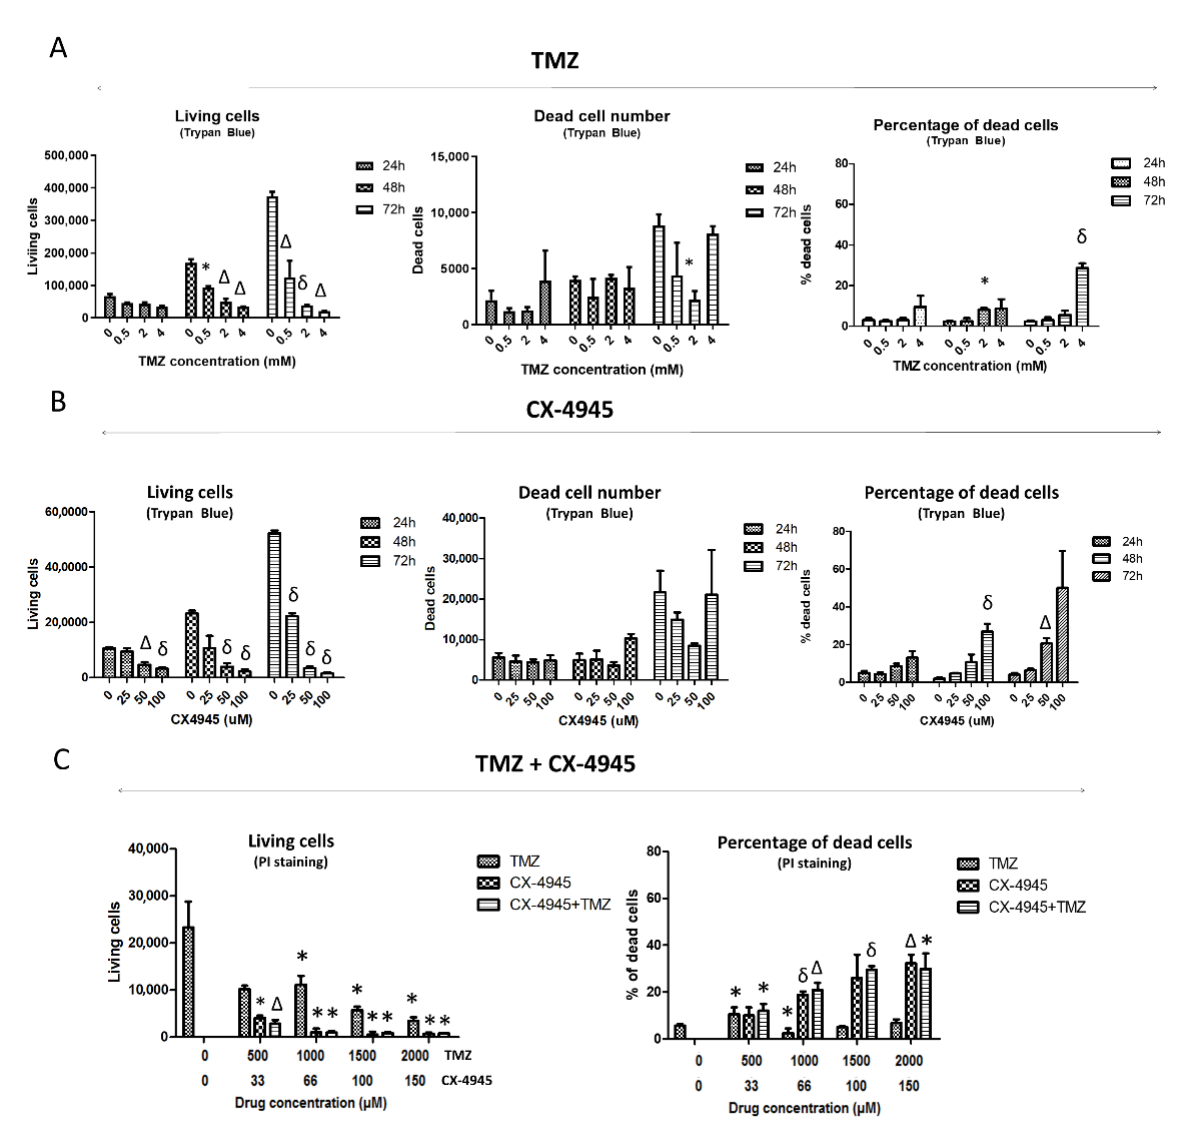
Figure 2. Cell viability/cell death assessment in TMZ, CX-4945, and TMZ+CX-4945-treated GL261 cells. Living and dead cell counting, as well as the percentage of dead cells assessed by Trypan Blue exclusion assay after ( A ) TMZ and ( B ) CX-4945 treatment (n = 2–3 for every case). ( C ) Living cells and propidium iodide (PI) positive cells percentage (i.e., dead cells) evaluated by flow cytometry after 72 h of TMZ, CX-4945, and TMZ+CX-4945 treatment (n = 3 for every case). Mean ± SD are shown. * ( p < 0.05), ∆ ( p < 0.01), and δ ( p < 0.001) mark statistical significance (Student’s t -test) comparing treated vs. control cells.